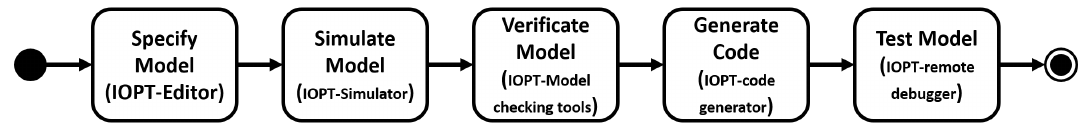
Figure 4. Development approach using the Input-Output Place-Transition (IOPT)